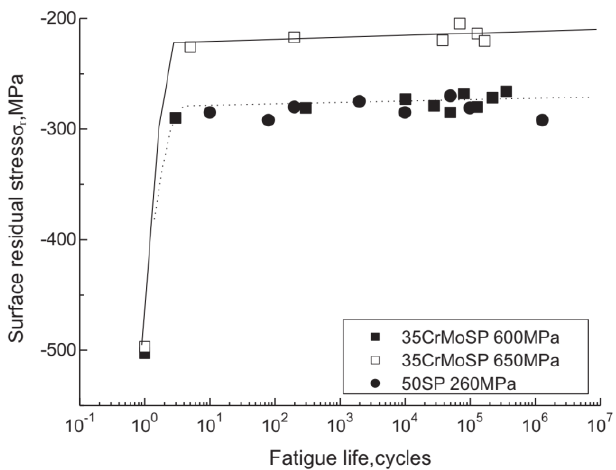
Figure 15. Comparison of compressive residual stress relaxation curves of microshot-peened 35CrMo and LZ50 steel specimens at relatively low fatigue stress levels compared to the material cyclic yield strengths. The specimens were subjected to rotary bending fatigue tests. Reprinted with permission from Ref. [13]. Copyright 2011 Elsevier.